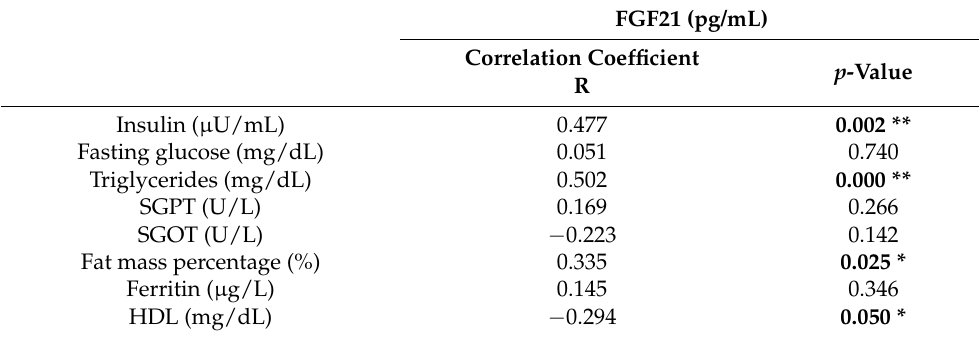
Table 3. Spearman correlation results between serum FGF21 and obesity-related metabolic dysregu- lation